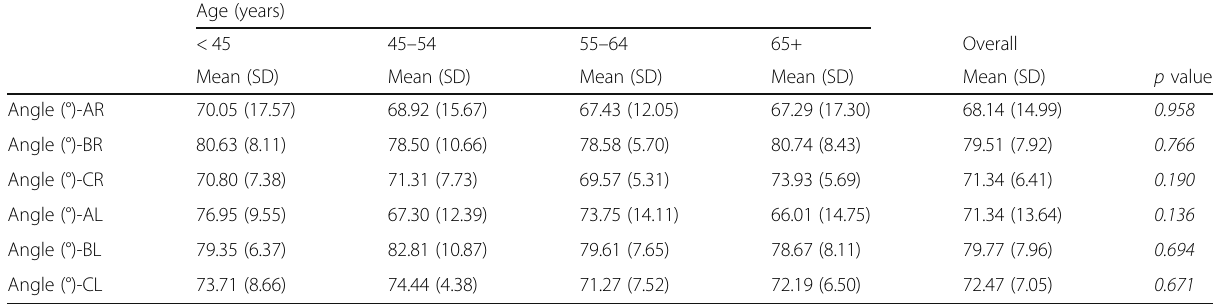
Table 5 Angle of the walls of the sinus by age